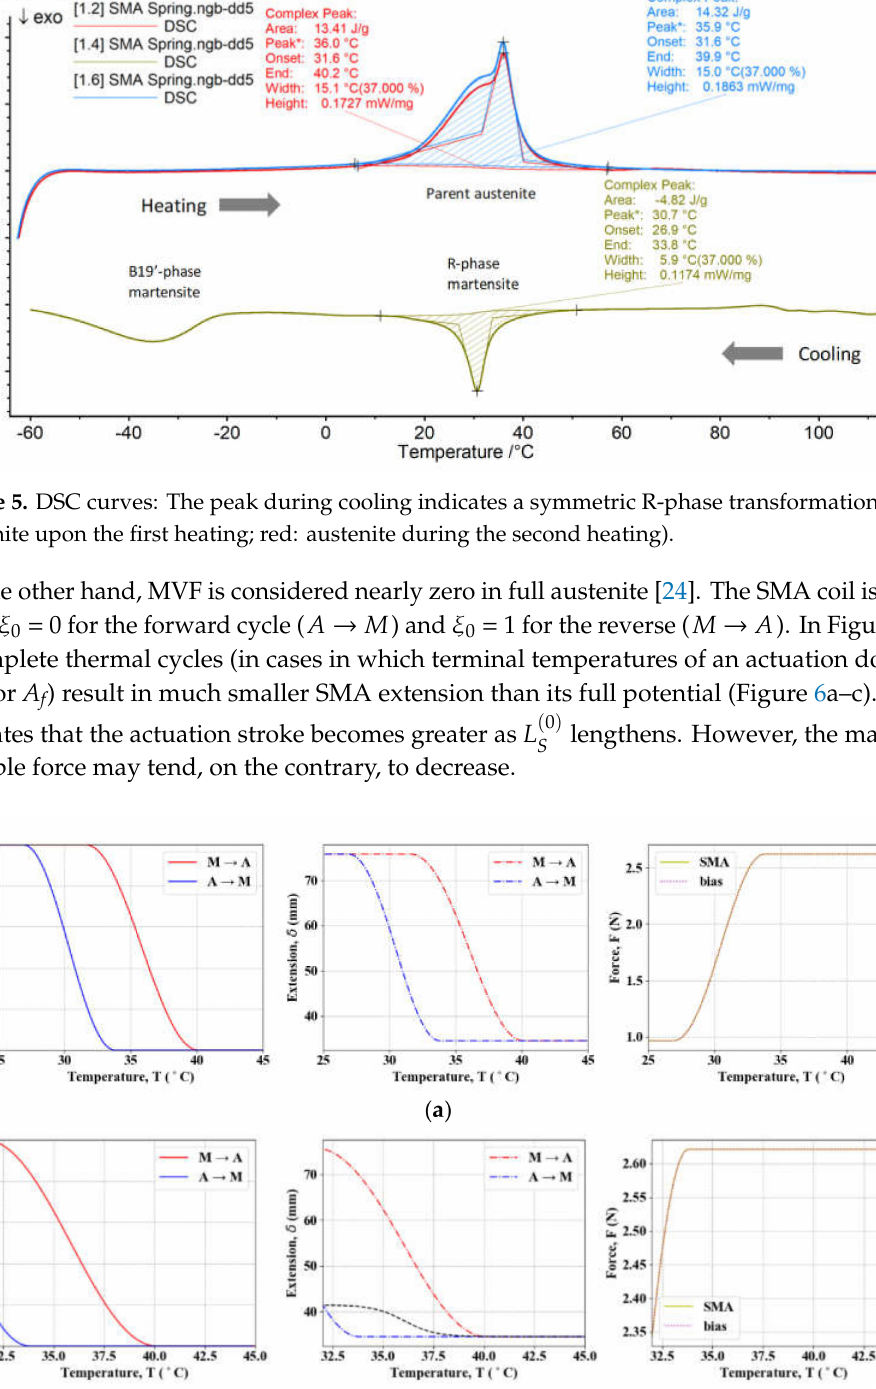
Figure 6. Simulation of SMA phase transformation behavior ( L = 300, L ( 0 ) S = 100, L ( 0 ) b = 100): ( a ) full cycle; ( b ) incomplete cooling; ( c ) incomplete heating; ( d ) behavior of multiple length SMA springs (black dotted lines in (b) and (c) indicate logistic approximation of recovery M → A . 3.2. SA: Spring Pitch Angle Variation Equation (14) indicates that a larger spring index ( C s ) and pitch angle ( α ) are advantageous to obtaining greater extension. However, in industrial practice, a C s of 4–16 is recommended and 6–12 is preferred by manufacturers so that α i and α f are less than 5 ◦ –10 ◦ and 20 ◦ –30 ◦ , respectively, to ensure robust contraction [25]. Figure 7 shows the variation in Θ with α i of [0 ◦ , 10 ◦ ] and α f of [0 ◦ , 30 ◦ ] with 10,000 samples generated using SALib. SA results in S α i = 0.018 and S α f = 0.982, which indicates that α i is far less important than α f . Θ is almost constant with an α i less than 4 ◦ , and we obtain Θ ∈ [0.94, 1.33] with mean ( µ ) of 1.1 and standard deviation ( σ ) of 0.12 on α i ∈ [0 ◦ , 4 ◦ ].